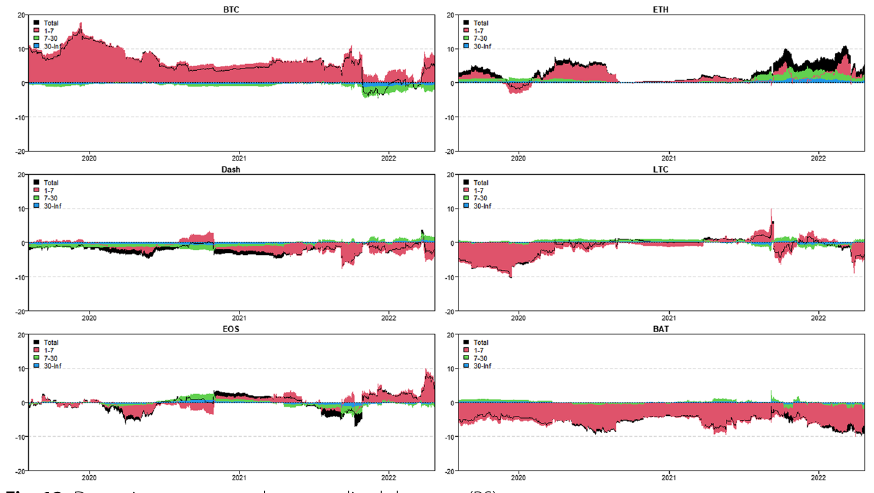
Fig. 12 Dynamic net connectedness—realized skewness (RS)